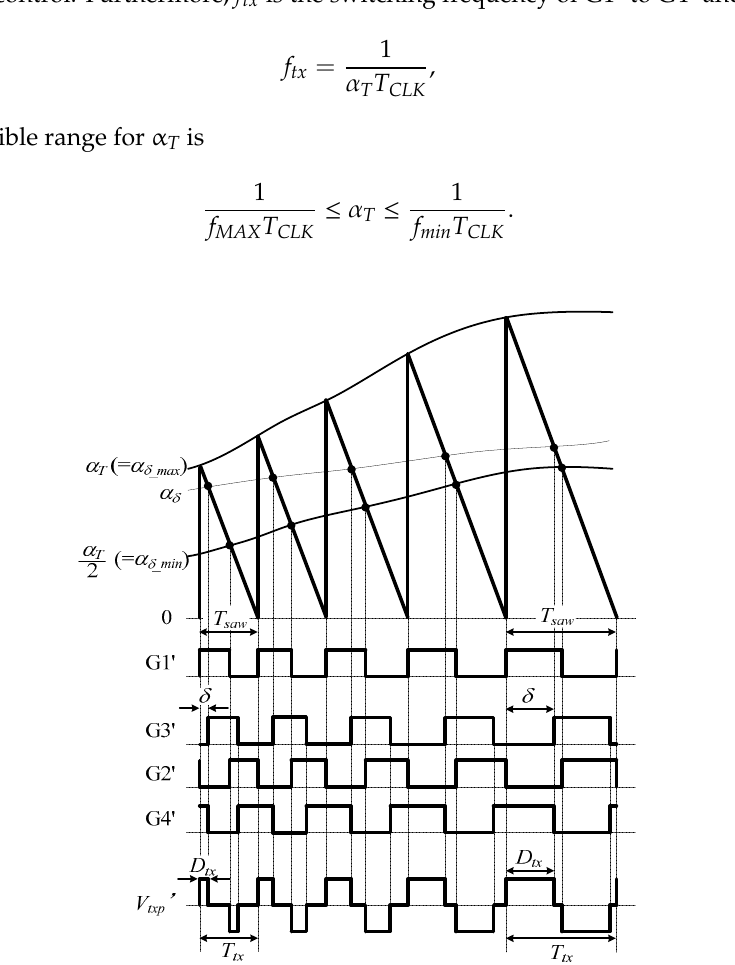
Figure 4. Principle of Field Programmable Gate Array PWFC function.